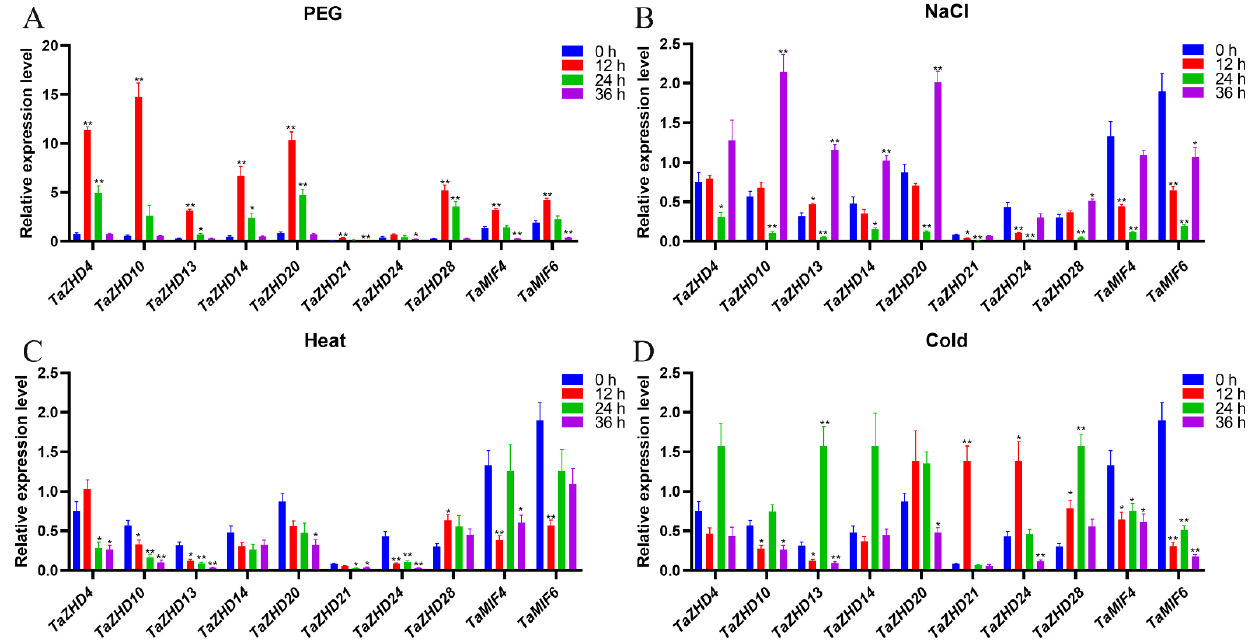
Figure 8. Expression patterns of TaZF-HD genes in response to PEG (polyethylene glycol) ( A ), NaCl ( B ), heat ( C ) and cold ( D ) treatments determined by real-time PCR. The expression level of the wheat actin gene was used as the internal control to standardize the RNA samples for each reaction. The values are the mean ± SE from three samples and significant differences were indicated as (*) p < 0.05 and (**) p < 0.01.